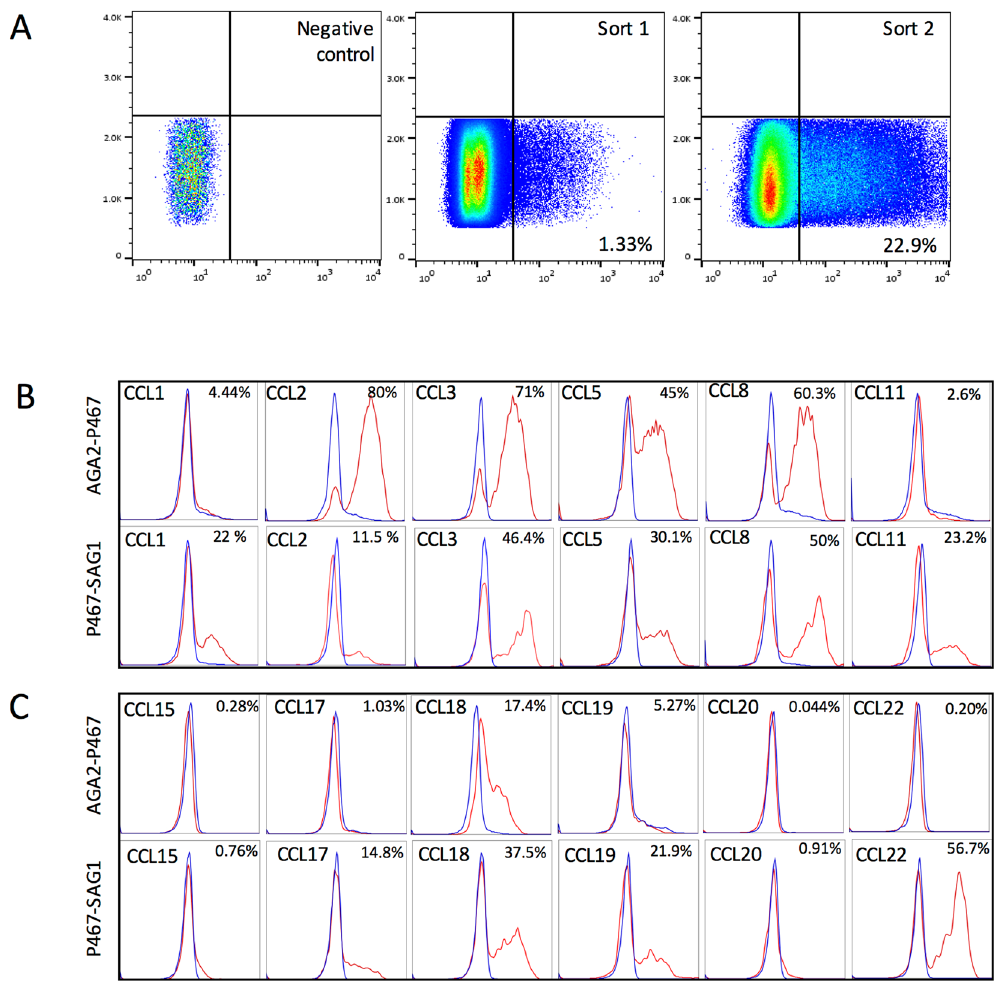
Figure 2. FACS screening of mini-library and retesting of recovered clones. ( A ) Fluorescence profiles of yeast surface display library incubated with streptavidin -AF647 alone (negative control), and incubated with biotinylated CCL5 plus streptavidin -AF647 (middle panel). The sorting gate was identified from the negative control, and was used to sort CCL5 binding yeast from the library. Yeast were sorted a second time similarly (right panel). Y-axis shows cell count and x-axis the fluorescence intensity on a log-scale. The proportions of cells within the sorting gate are indicated as a percentage. ( B,C ) Binding of P467_RHIPU to a panel of chemokines. Yeast surface display fluorescence profiles showing the binding of P467_RHIPU (N-terminal AGA2 fusion, top panels), and C-terminal SAG1 fusion) bottom panels, to a panel of CC chemokines as indicated in the figure. Yeast expressing P467_RHIPU are shown in red, and control yeast bearing empty vector surface display plasmid are shown in blue. Y-axis shows cell count, and x-axis the fluorescence intensity on a log-scale. The proportion of cells exceeding background are indicated as a percentage. The peptide sequence prefix indicates the identity, and suffix RHIPU indicates the species Rhipicephalus pulchellus